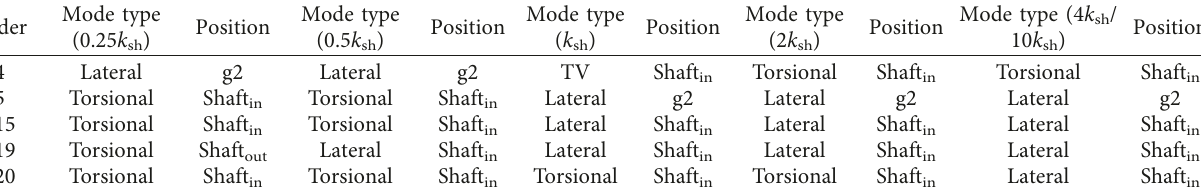
Figure 21: The effect of shaft stiffness on mode shape. (a) First-order translation mode. (b) First-order torsional mode. Table 5: Change of dominant vibration at different stiffness values.